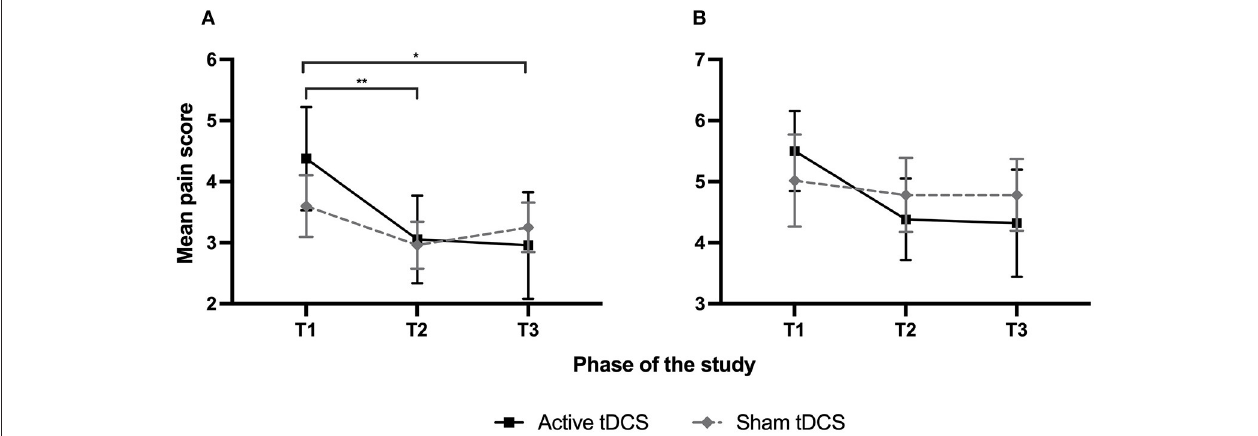
FIGURE 2 | The average daily pain for sham and active treatment groups was gathered using the 0–10 NRS from the pain logbooks. T1 represents the 7 days of baseline, T2 corresponds to the 5 days of tDCS treatments, and T3 represents the 7 days of follow-up. Each point represents a group mean ± SEM (standard error of